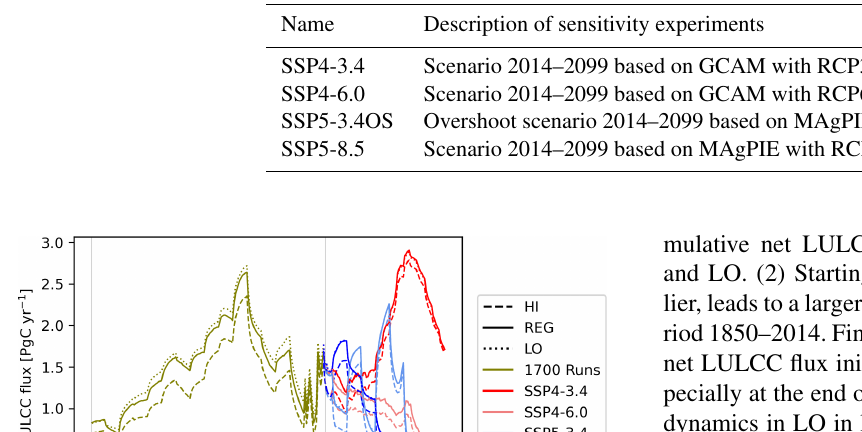
Table 3. Overview of future sensitivity experiments, continued from simulations with starting year 1700 for all three LULCC scenarios (see Table 2).